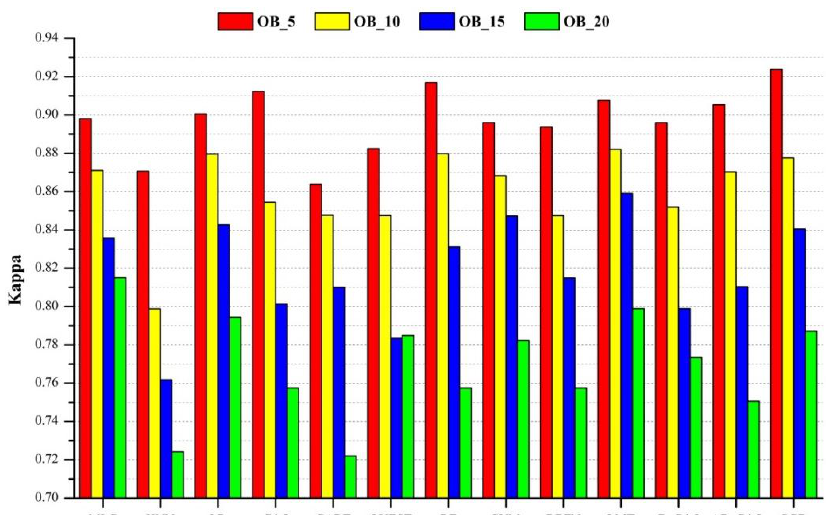
Figure 8. Objected-based supervised classification